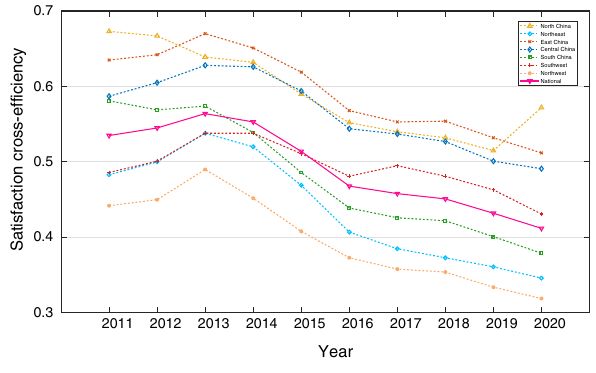
Fig. 4 Trends in satisfaction cross-efficiency averages of the W–E–F nexus input–output by region from 2011 to 2020